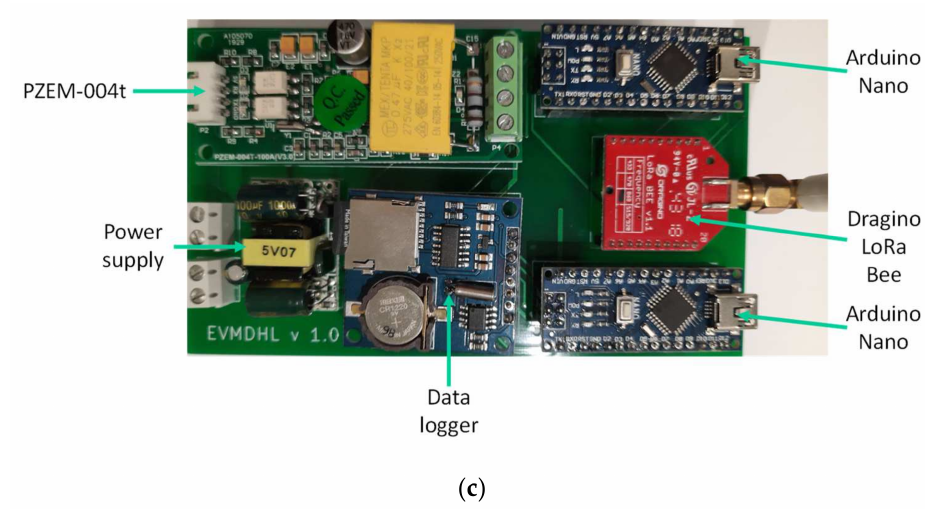
Figure 7. PCB of the EVMDHL with battery power supply: ( a ) front side, ( b ) back side and ( c ) assembled with real components.